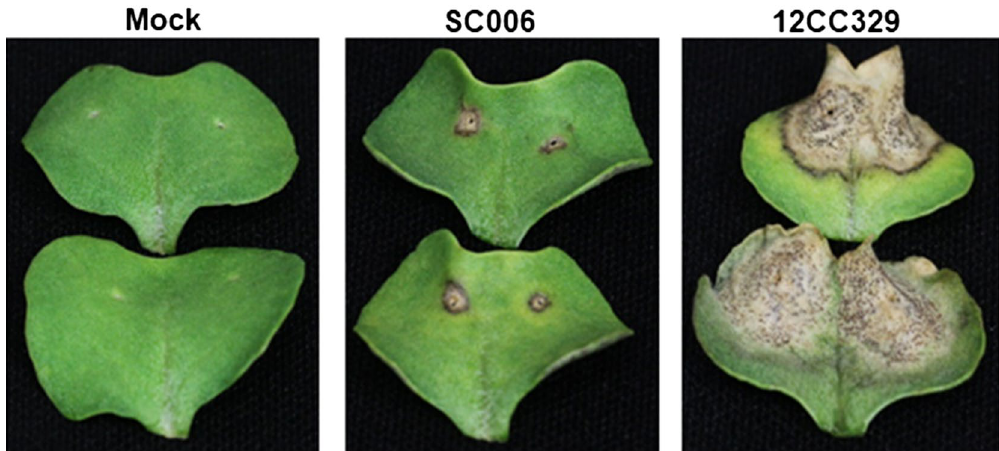
Figure 1. Phenotypic characterization of B. napus DH24288 ( Rlm1 ) in response to L. maculans infection. Cotyledons of DH24288 were inoculated with water (Mock), L. maculans isolate SC006 ( AvrLm1 ) or 12CC329 ( avrLm1 ). Photos were taken at 14